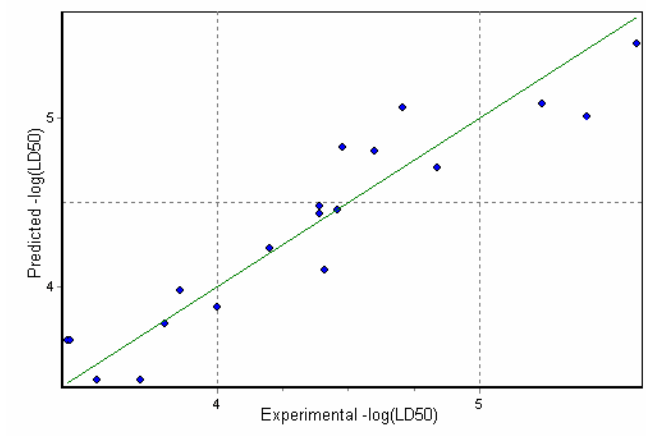
Figure 5. Correlation of Predicted versus Experimental toxicities for model C (Eqn.6)